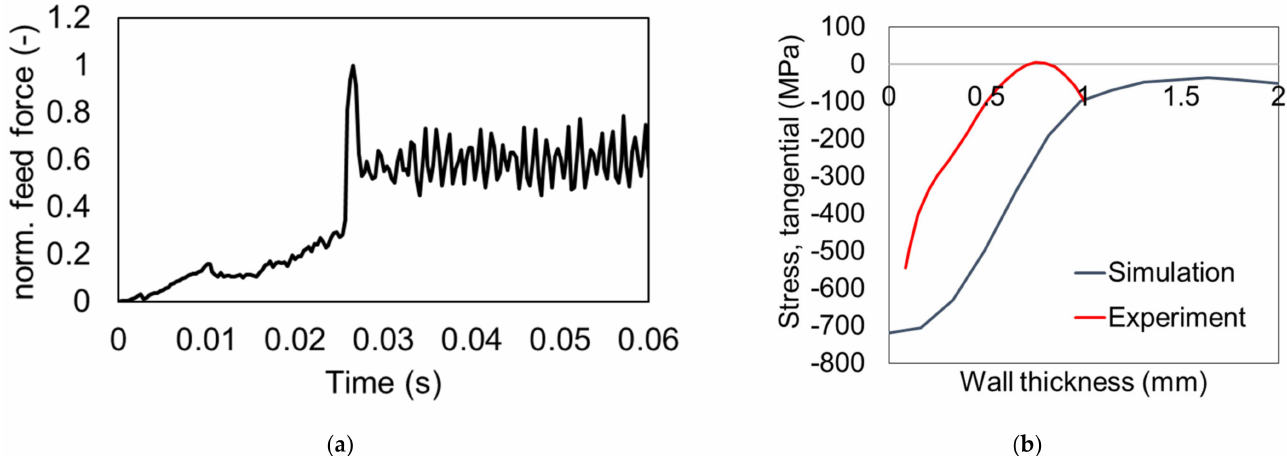
Figure 9. Simulated feed force evolution applying a feed of 0.64 mm/rev and a cutting speed of 472.5 m/min ( a ) and tangential residual stresses after one rotation with a feed of 0.64 mm/rev and a cutting speed of 472.5 m/min ( b